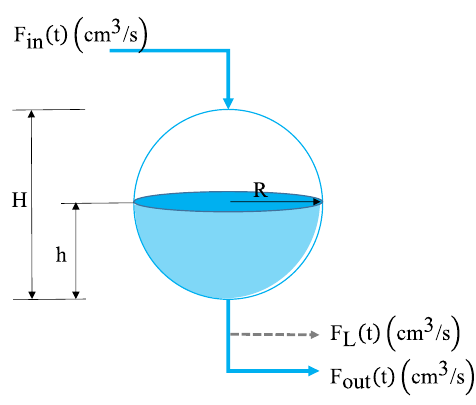
Figure 2. Physical diagram of the spherical tank system. Table 1. Parameters of the spherical tank system [1,11].